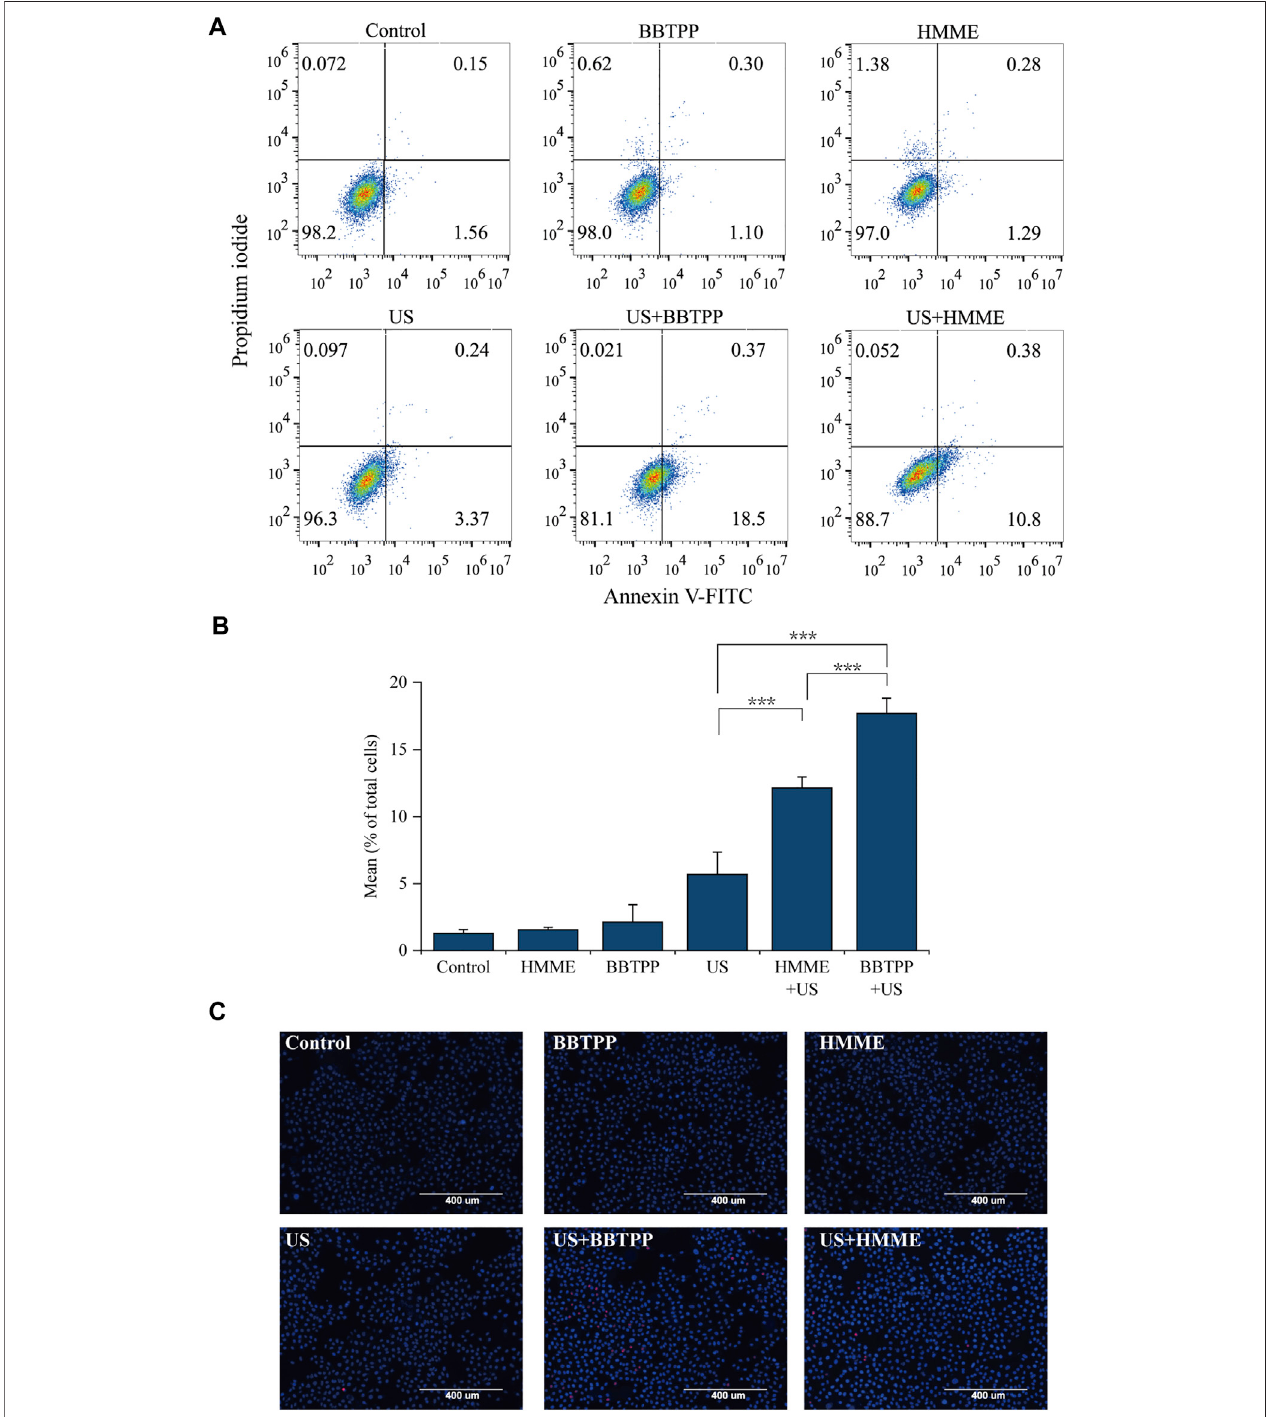
FIGURE 2 | Effects of BBTPP and HMME induced apoptosis under sonication were determined with Annexin V-FITC/PI and Hoechst 33342/PI double-staining assays in PC-9 cells (A) Flow cytometry results with Annexin V-FITC/PI double-labeling in PC-9 cells (B) A statistical graph of the ratio of apoptosis among different experiment groups inAnnexin V-FITC/PI staining. Thedata werepresented asthemean ± standard deviation. Theapoptoticcells included the Annexin V+/PI − cellsand Annexin V+/PI + cells (C) Fluorescent assay of Hoechst 33342/PI staining. US: ultrasound; *** p ＜ 0.001.